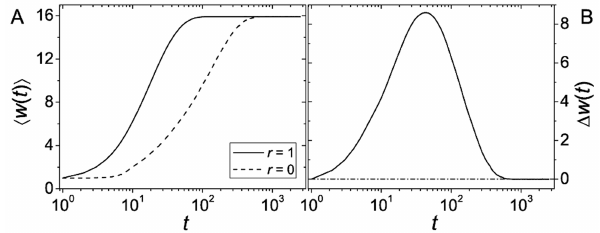
Figure 2. Dependence of the recombinational advantage on fitness landscape ruggedness. The figure shows time series of different observables for varying ruggedness parameter l . (A, B) Mean fitness S w T . (C, D) Fitness of the fittest individual S w max T . (E, F) Entropy S S T of the genotype frequency distribution as a measure for genetic diversity. Left columns shows quantities for populations with r ~ 0 and r ~ 1 separately, the right column shows the difference. Parameters are N ~ 2000 , N m ~ 4 , and c ~ 1 .